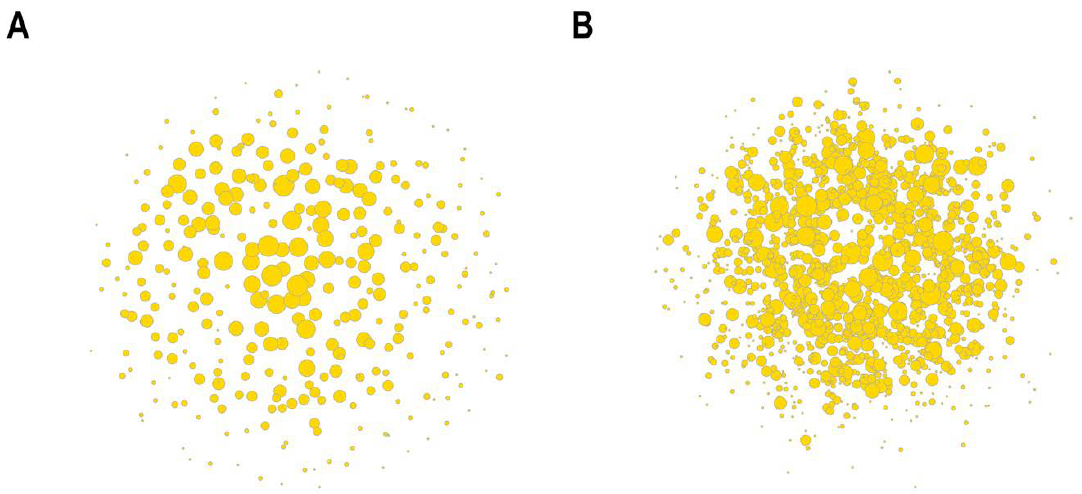
Figure 1. Map of users active two weeks before and two weeks after the march. ( A ) shows users active two weeks before the march. ( B ) shows users active two weeks after the march. Table 1. Number of users active in other Australian far-right Facebook pages before and after the march.